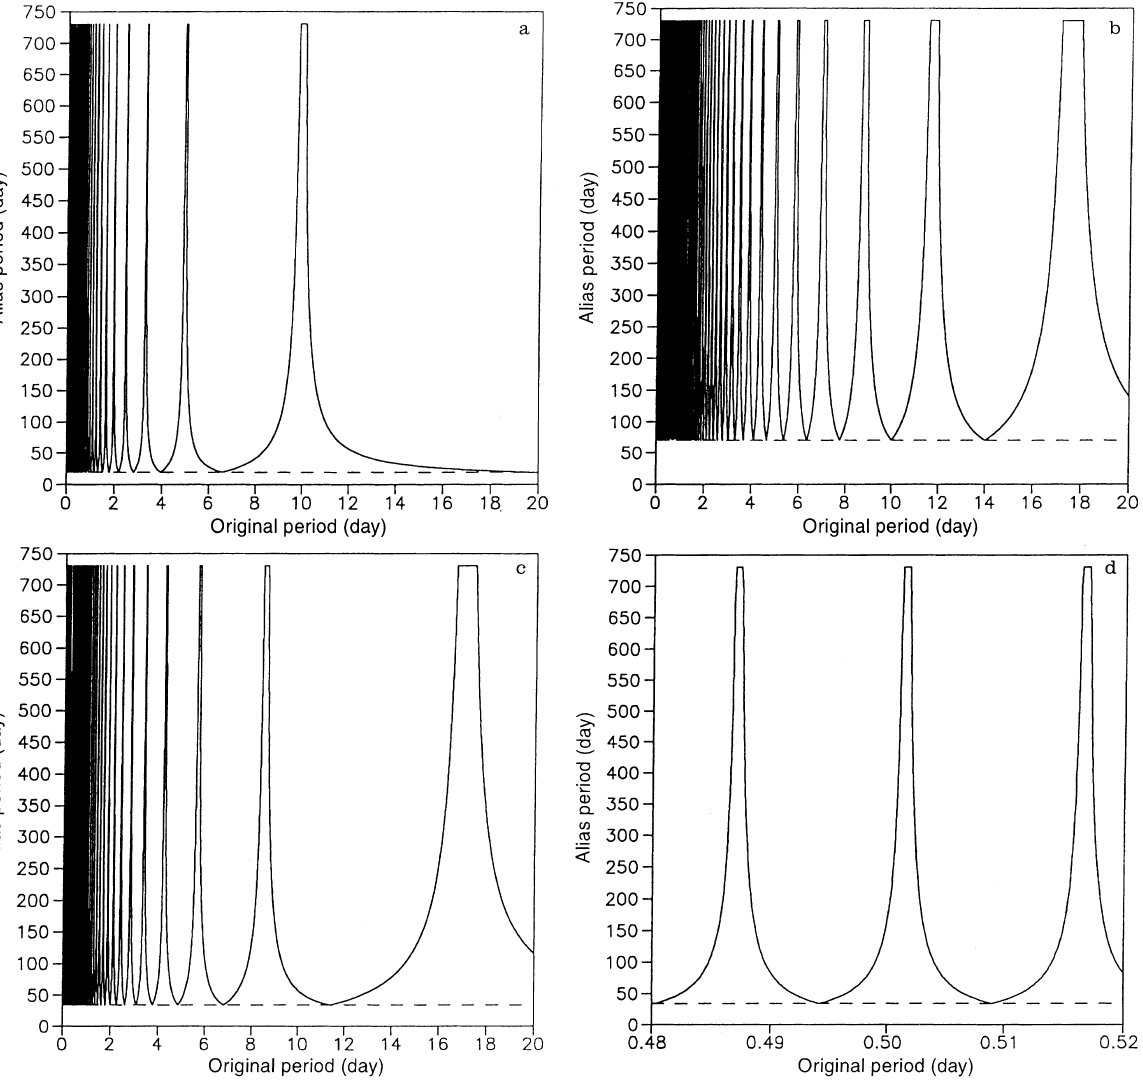
Fig. 1a–d. Alias period as a function of original period of a harmonic signal under the sampling schemes of a TOPEX/POSEIDON, b ERS (35-day repeat orbit) and c Geosat; d is a zoom of c centred at 0.5